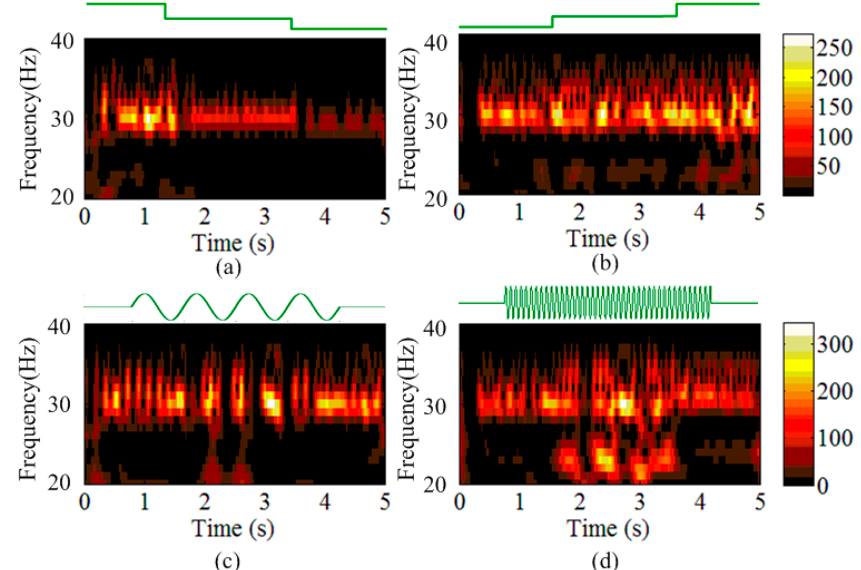
Figure 6. The wavelet transform of the frequency-domain analysis. ( a ) The oscillation dynamics under the modulation of negative direct current; ( b ) The oscillation dynamics under the modulation of positive direct current; ( c ) The oscillation dynamics under the modulation of low-frequency AC stimulation; ( d ) The oscillation dynamics under the modulation of high-frequency AC stimulation.